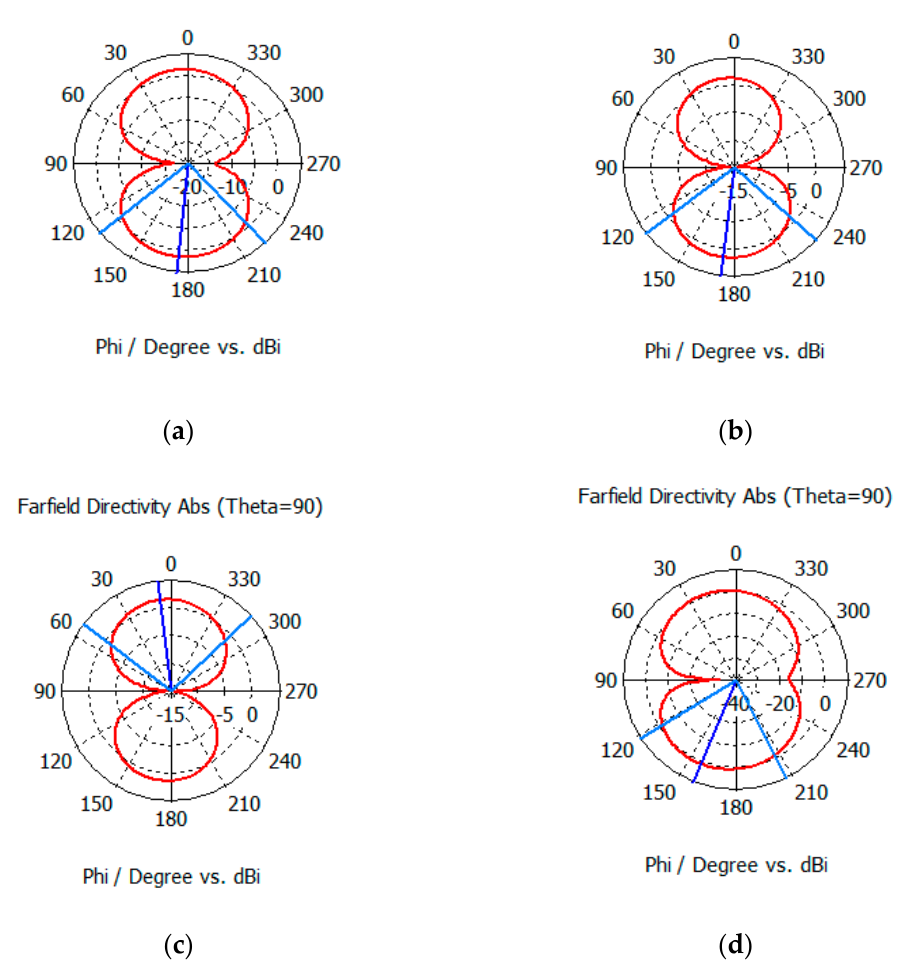
Figure 10. Radiation pattern at 3.5 GHz with DGS: ( a ) D1(ON) and D2(ON); ( b ) D1(OFF) and D2(ON); ( c ) D1(ON) and D2(OFF); ( d ) D1(OFF) and D2(OFF).